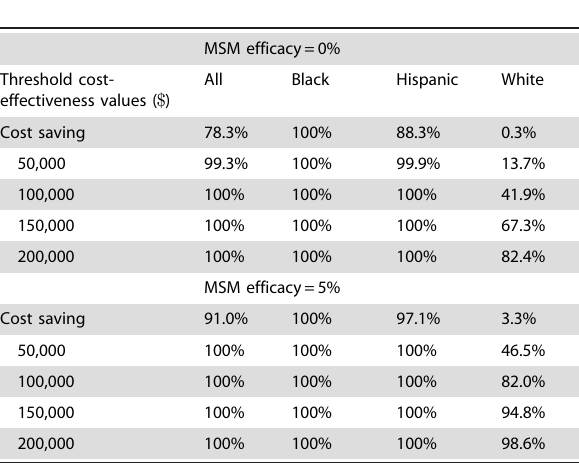
Table 6. Probability of the cost of newborn circumcision per HIV-related quality-adjusted life year saved falling within selected thresholds for all, black, Hispanic and white U.S. males, with efficacy for the prevention of HIV among MSM equal to 0% and